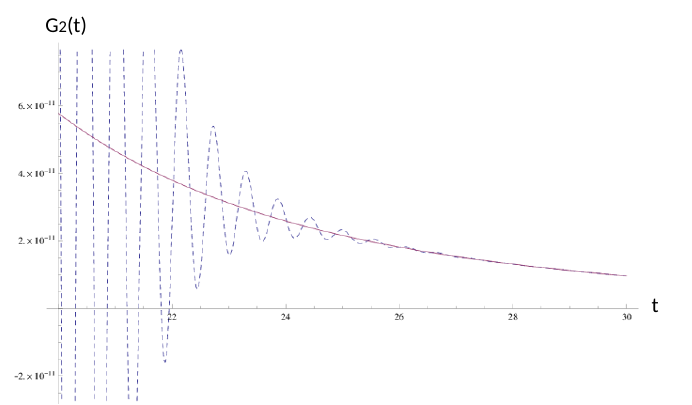
Figure 2 . The dash line shows the numerical result for G 2 ( t ) from the poles and cut contributions with their expressions (See main text for details) by setting (cid:11) = 2 : 4, (cid:10) = 10, (cid:13) T n +1 S n = 15. We also set (cid:1) = (cid:13) (cid:10) (cid:11) (cid:0) 2 = (cid:0) 0 : 25, which corresponds to the case of narrow resonance. M The solid line is also for the evolution of G 2 ( t ) in the late times ( t (cid:29) 1 = (cid:10)) given by (4.33) with the same parameters